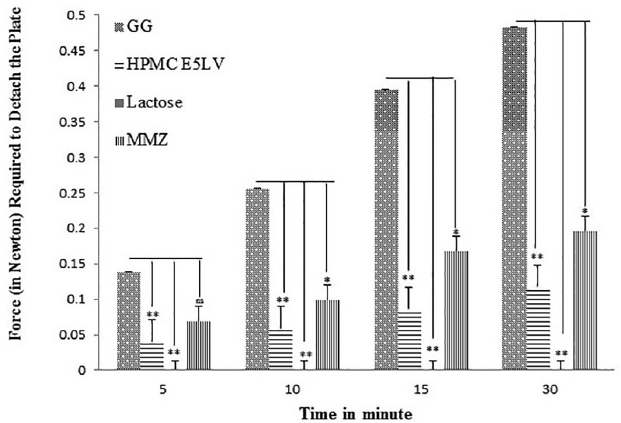
FIGURE 3 - Compression between Mucoadhesive Strength of Guar Gum and HPMC E5LV: Hydroxyl Propyl Methyl Cellulose E5LV (Standard) and MMZ: mucilage of Manilkara zapota (Test Materials) and Lactose (Control). Values are expressed as mean ± SEM (n = 6). Data was analyzed by one way ANOVA followed by Dunnett test (Compared with standard Guar Gum), (ns) p>0.05; *p<0.05;